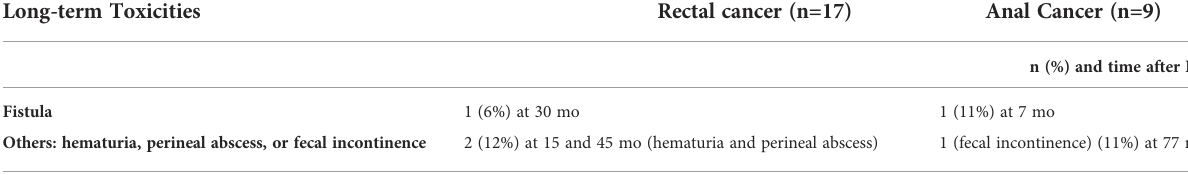
Table 4 The rate of developing long-term toxicities associated with anorectal radiation therapy (RT) after prior prostate RT. Long-term Toxicities